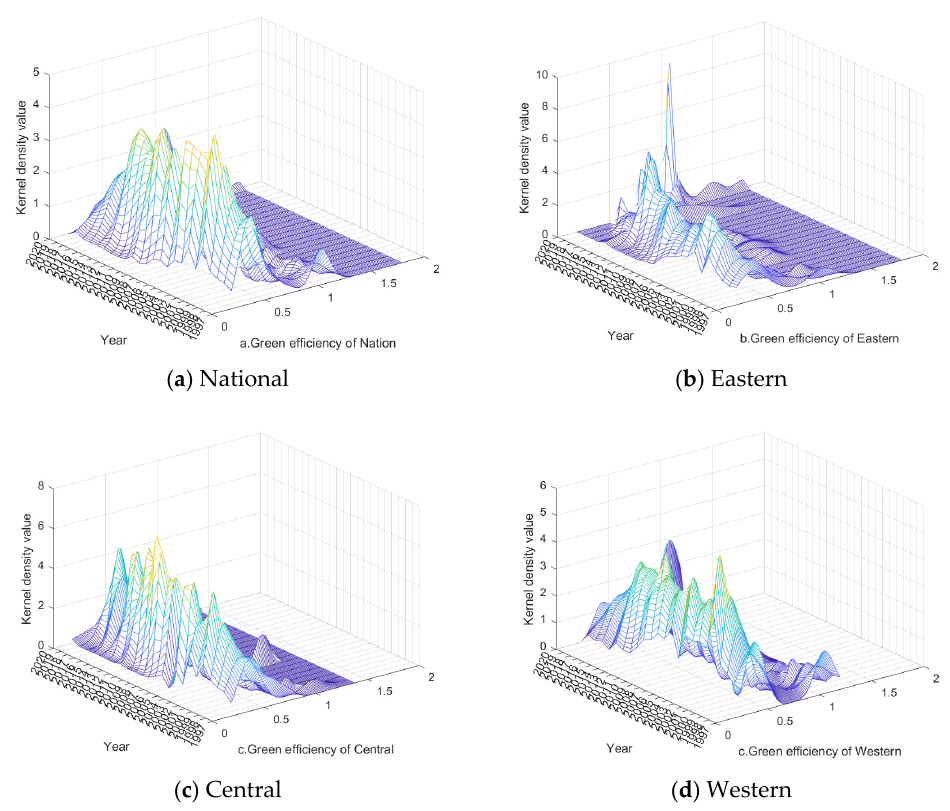
Figure 2. Evolution trends of green efficiency of agricultural water use in China.